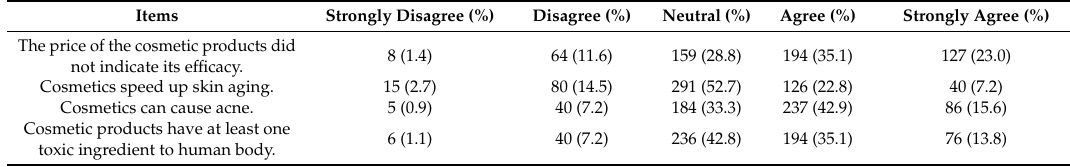
Table 7. Response of participants to the questions on perception towards cosmetic.